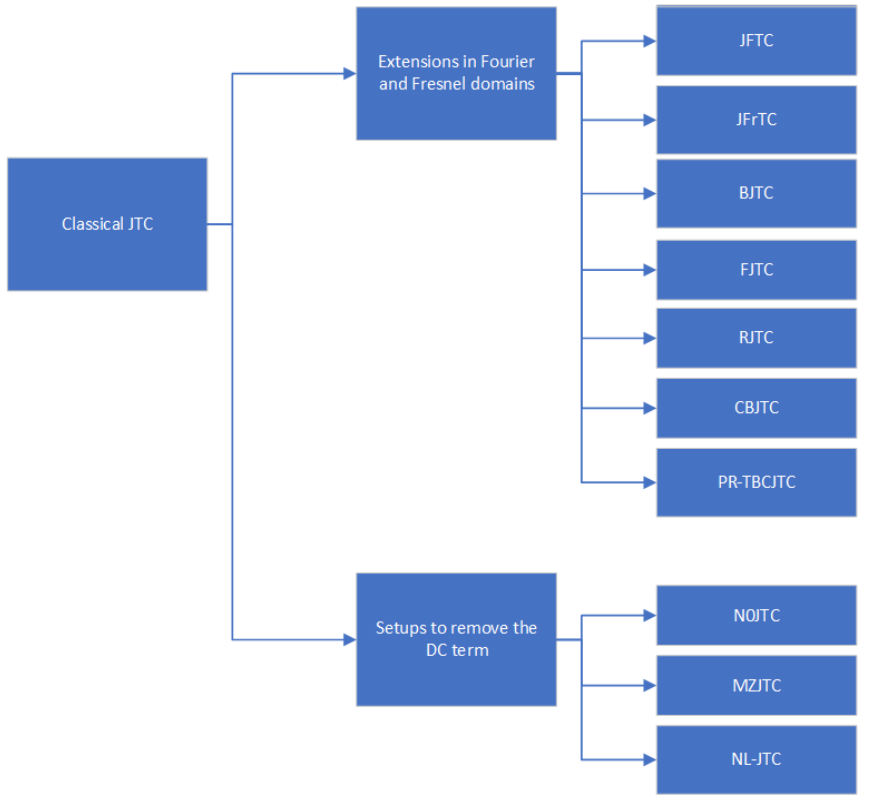
Figure 3. Overview of various alternatives to the classical JTC, where: JFTC—joint Fresnel transform correlator, JFrTC—joint fractional Fourier transform correlator, BJTC—binary JTC, FJTC—